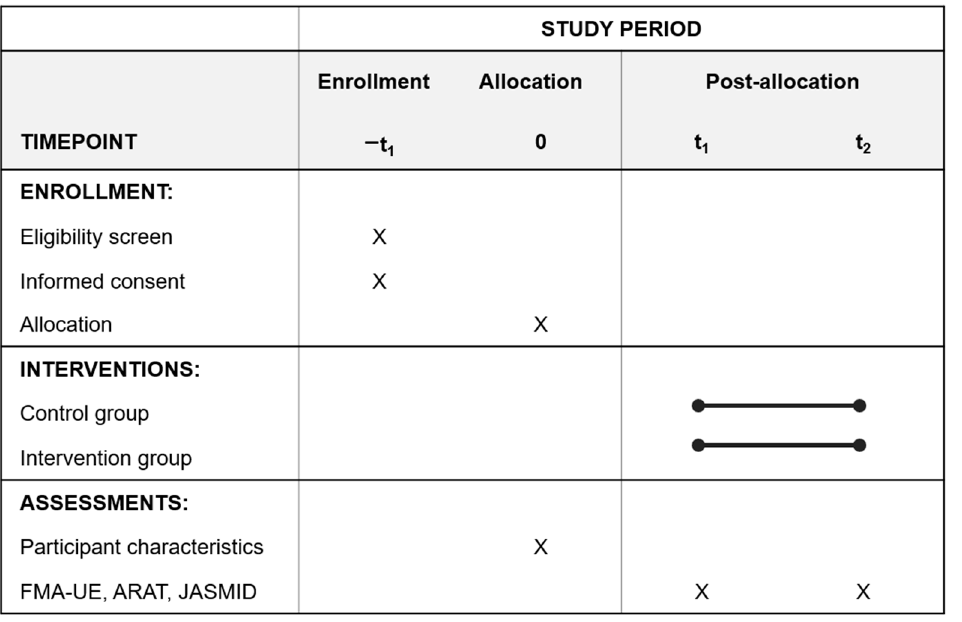
Figure 1. Schedule of enrollment, interventions, and assessments. FMA-UE, Fugl-Meyer assessment of the upper extremity; ARAT, Action Research Arm Test; JASMID, Jikei Assessment Scale for Motor Impairment in Daily Living. Investigators will obtain informed consent from patients who meet the